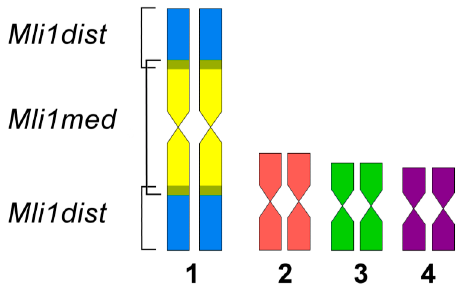
Figure 1. Scheme of the dissection of the MLI1 chromosome for generation of region-specific DNA probes. Medial part of MLI1 (in yellow color): Mli1med DNA probe; distal parts of MLI1 (in blue): Mli1dist DNA probe. Overlapping regions are shown in grey.